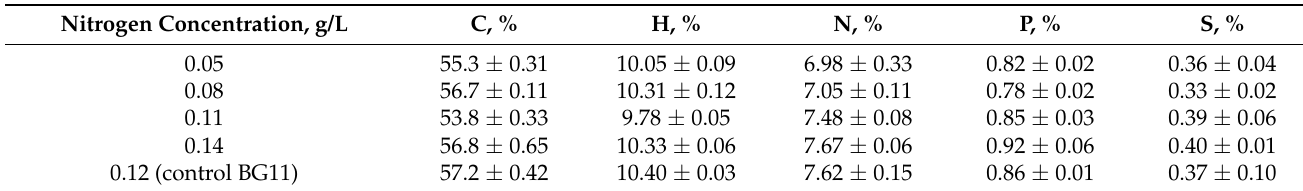
Table 2. Elemental composition of the microalgae Chlorella sp. biomass when the algae are grown in a nutrient medium supplemented with the liquid waste from the production of biogas from distillers’ grain.